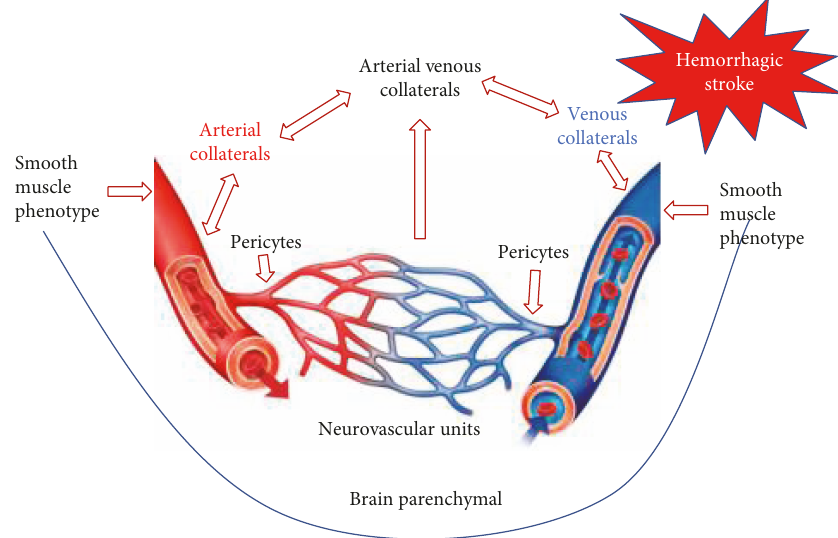
Figure 1: Neural vascular mechanisms for the cerebral blood fl ow autoregulation in the present